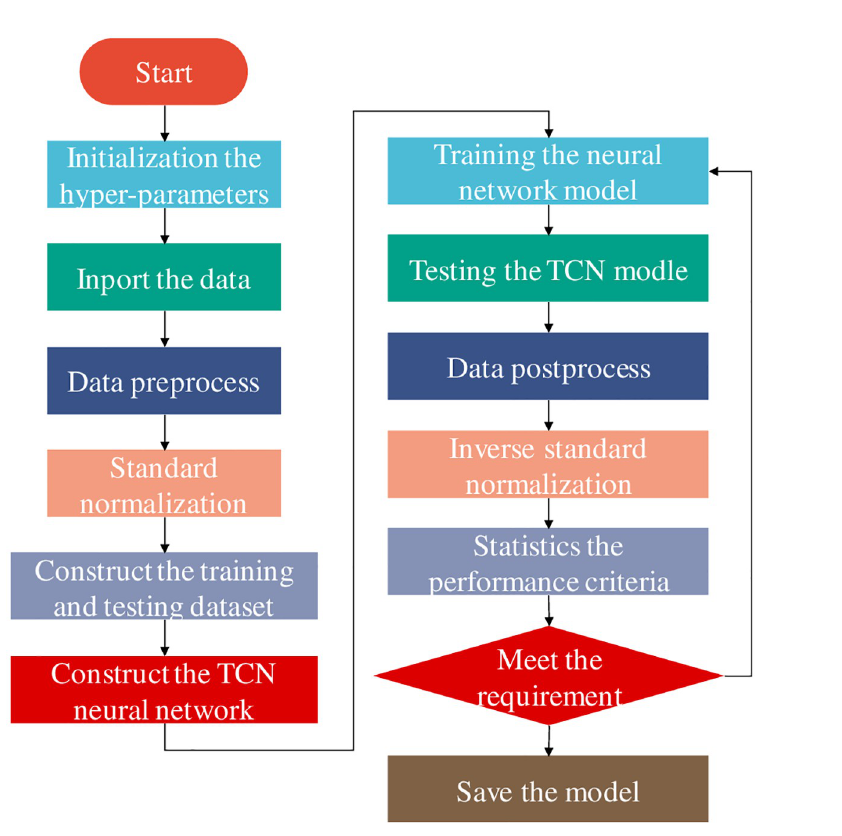
Fig 6. Network structure of TCN time series prediction model.